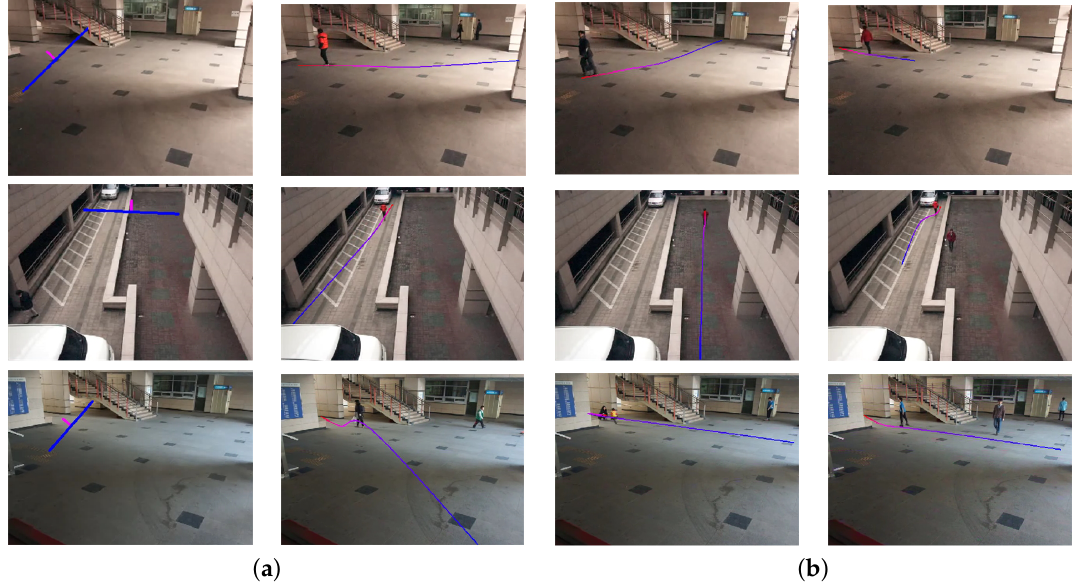
Figure 20. Results of the object search using the moving direction. ( a ) Line setting; ( b ) the results of the search.